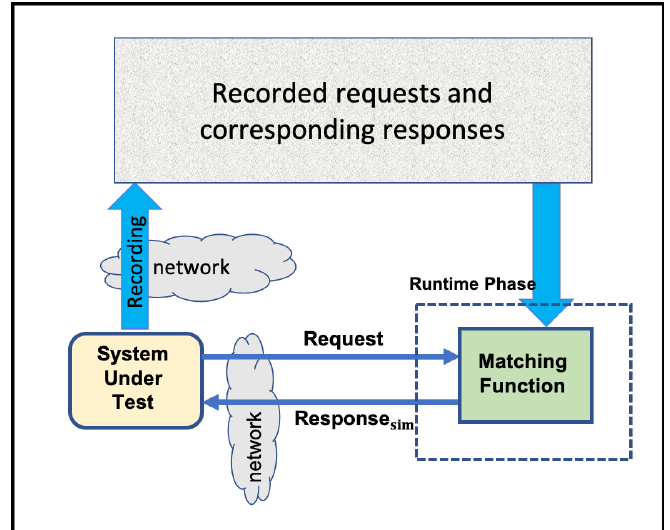
Figure 1. Record and replay